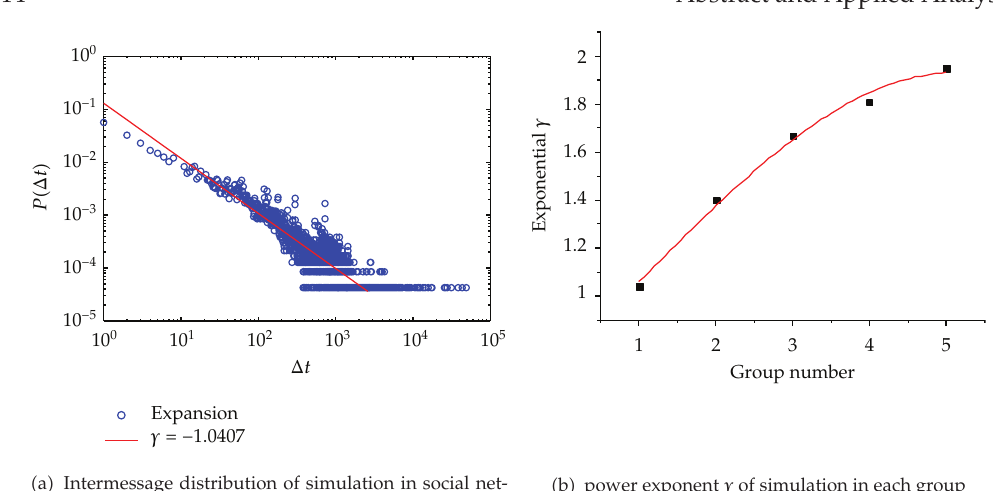
Figure 11: Simulation results with real social